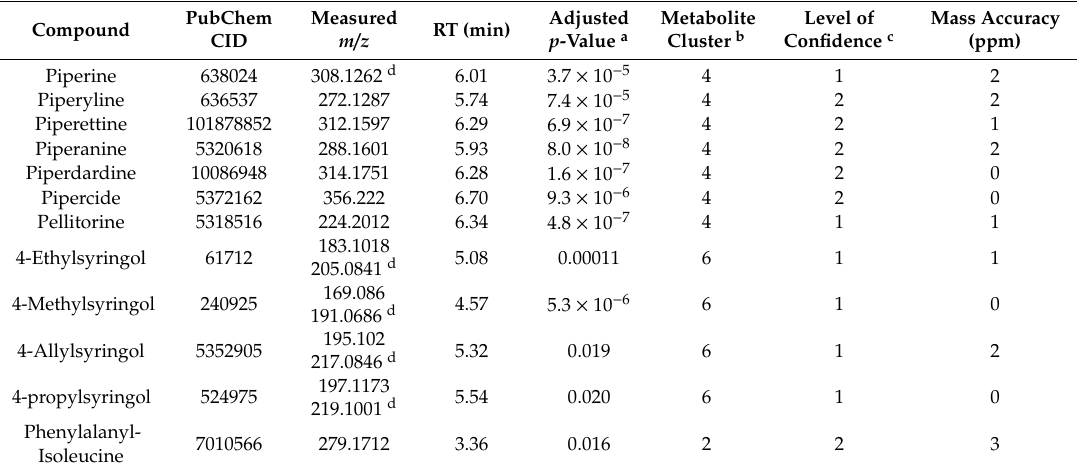
Table 2. Selected compounds significantly elevated in digests of processed meat compared to digests of non-processed